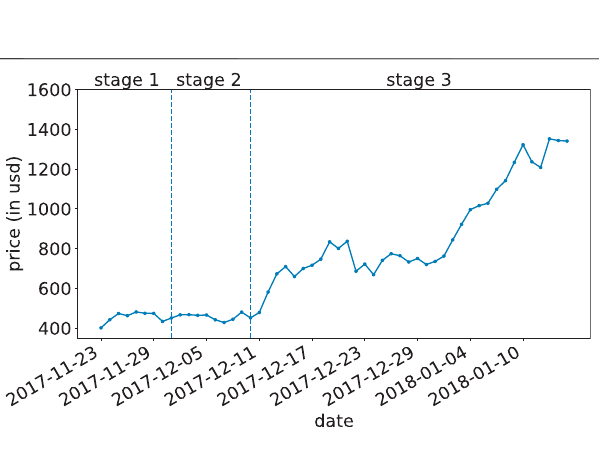
Frontiers in Physics |